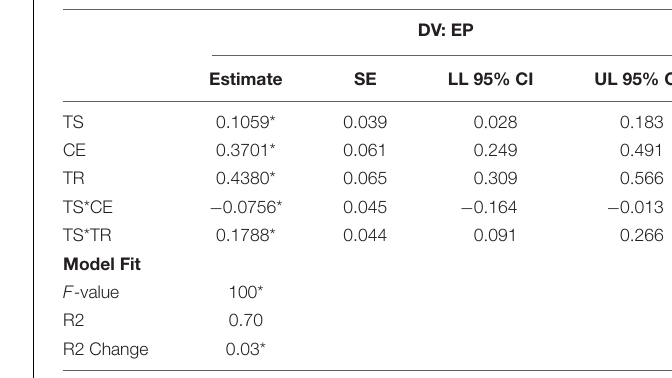
TABLE 6 | 5000 Bootstrap Results for PROCESS Model No.2, moderation analysis with two